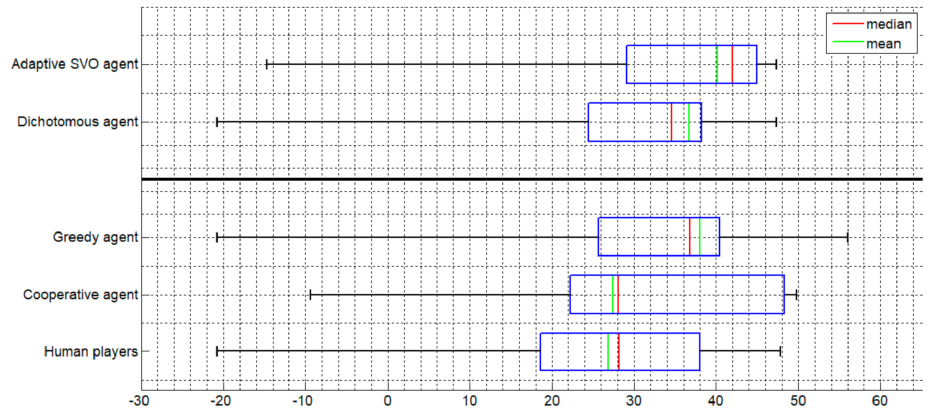
Figure 3. Agent plays as a type 2 (orange)